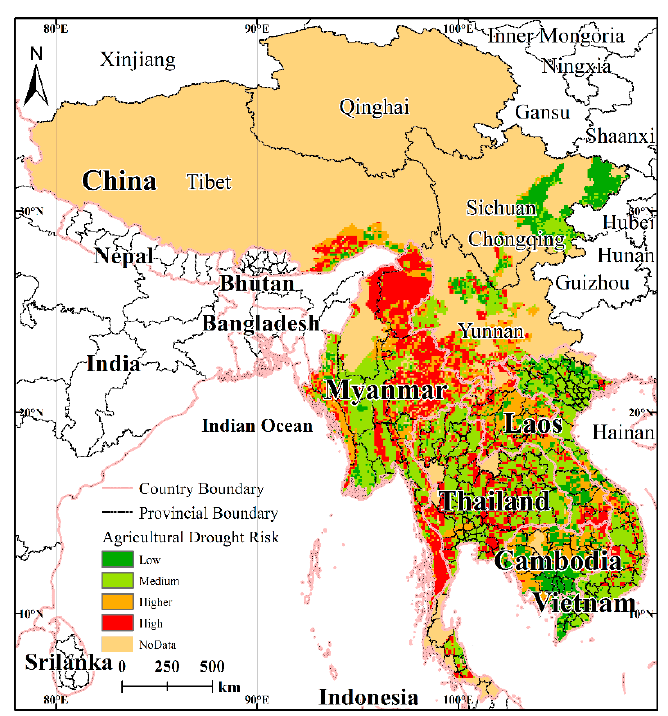
Figure 12. Distribution of drought risk in the LMR.